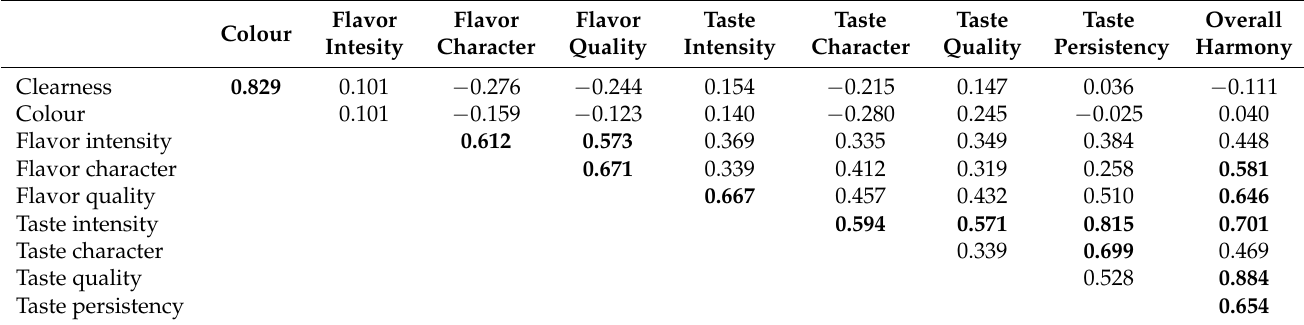
Table 14. Pearson correlation coefficients ( r ) amongst 10 organoleptic parameters of white wine from Debrecen-Pallag, Hungary. Bold figures represent the significant ( p < 0.05) correlation coefficient values among parameter pairs.